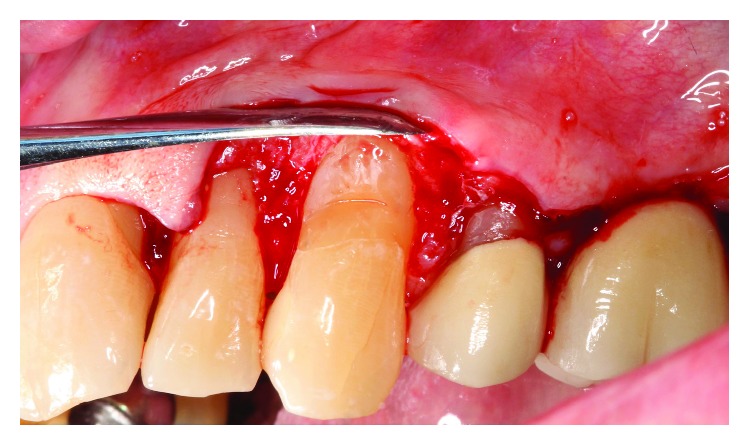
Postodontoplasty #11.